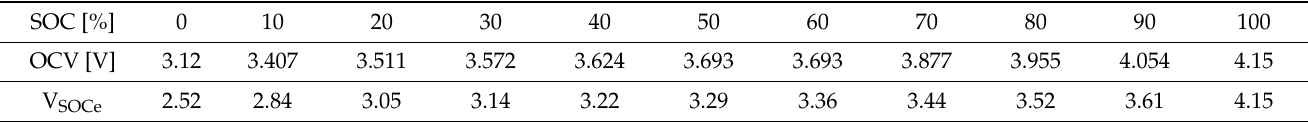
Table 2. SOC versus OCV and V SOCe .